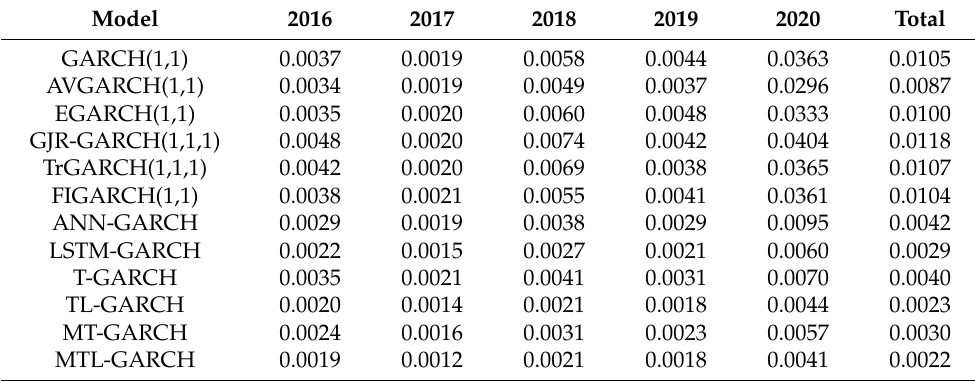
Table 3. MAE by volatility model and year.